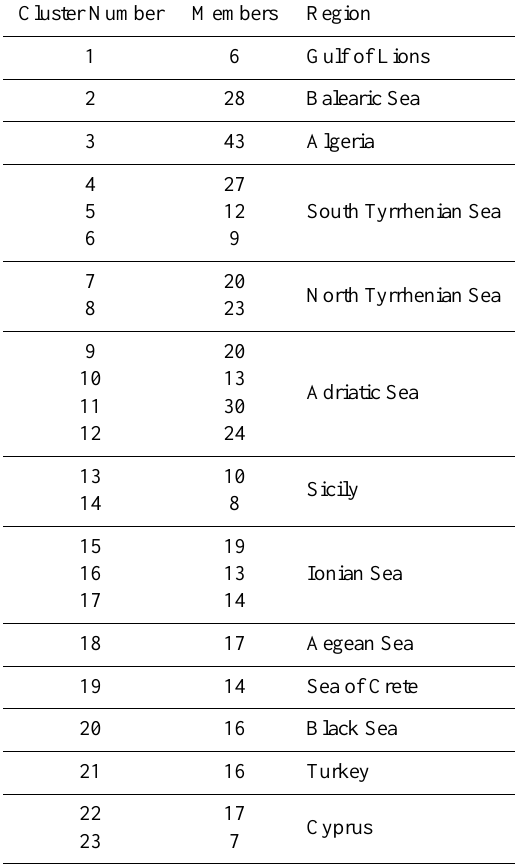
Table 1. Classification of Mediterranean intense cyclones as de- rived from the cluster